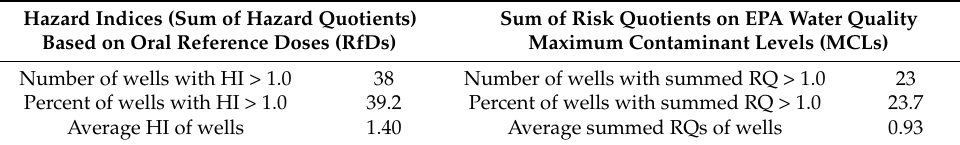
Table 8. Comparison of summary statistics for: health risk as measured by hazard indices (HIs) vs. well water quality as measured by the sum of risk quotients (RQs).